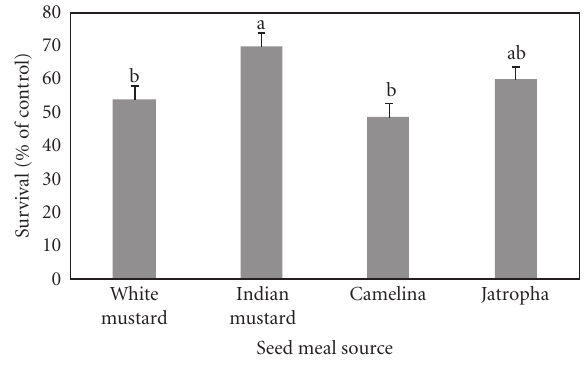
Figure 4: Main e ff ect of “seed meal source” on pigweed survival. Means followed by the same letter are not di ff erent at P < 0 . 05 by Fisher’s protected LSD. The e ff ect of “seed meal source” was not significant for pigweed emergence; therefore, data is not shown. Data are means (four replications) ± SE.